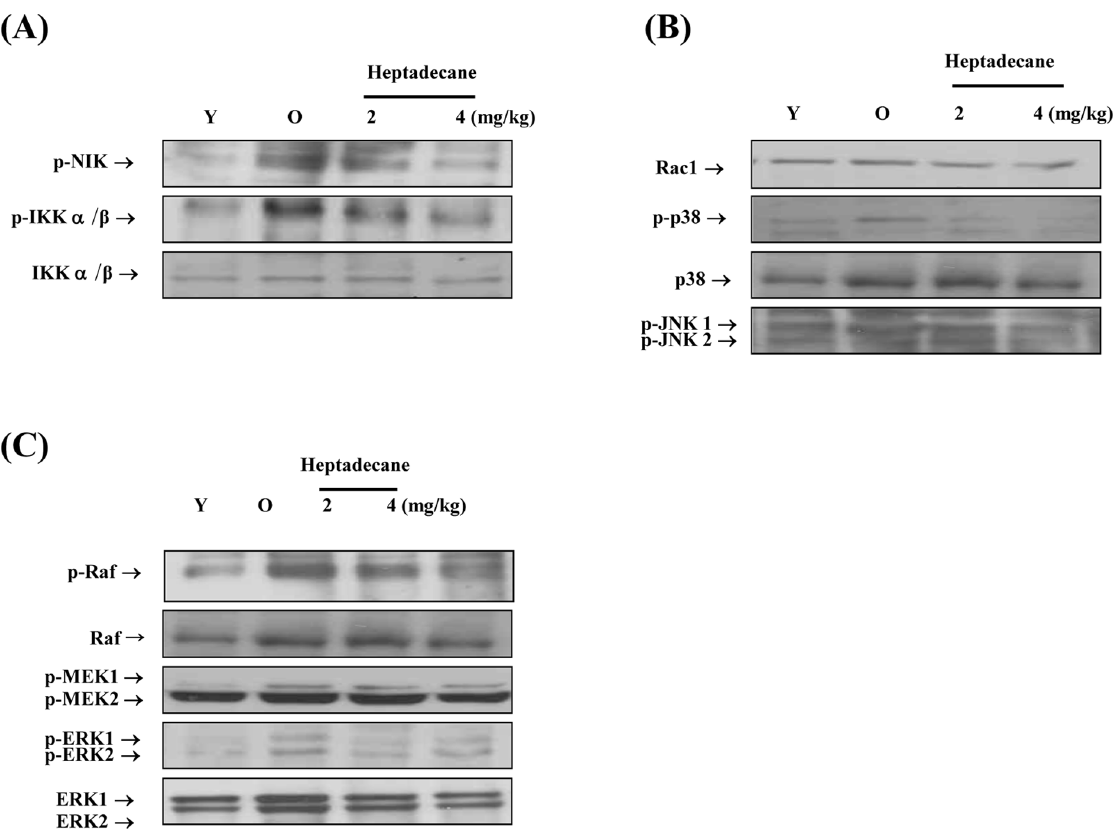
Figure 2. Heptadecane suppressed the age-related activations of NIK/IKK and MAPKs. Western blot on renal cytoplasmic extracts (40 m g protein) from young, aged, and aged rats fed heptadecane. (A) Phosphorylations of P38 and JNK are designated p-p38 and p-JNK1/2. (B) Phosphorylations of NIK and IKK are designated p-NIK and p-IKK a / b . (C) Phosphorylations of MEK1/2 and ERK1/2 were detected using antibodies of p- MEK1/2 and p-ERK1/2. One representative blot of each protein from three experiments that yielded similar results is shown. Young rats (9 months of